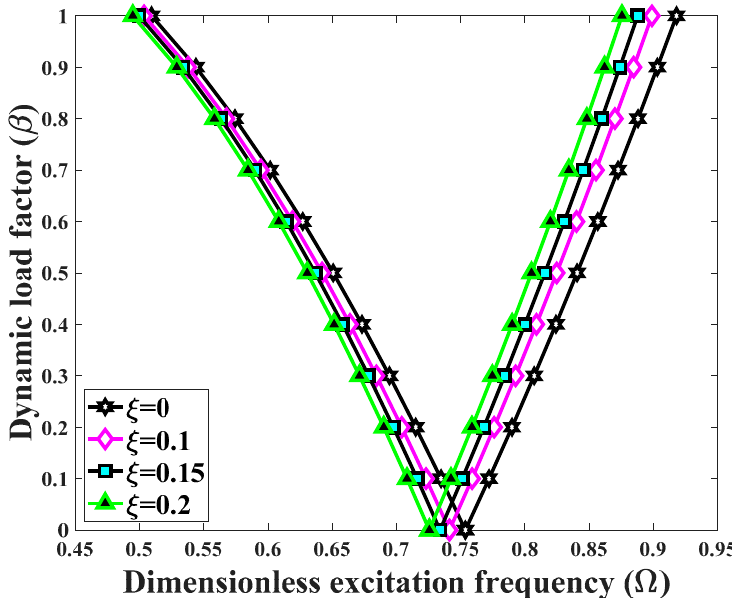
ξ on the DIR for a BD-FG porous cylindrical